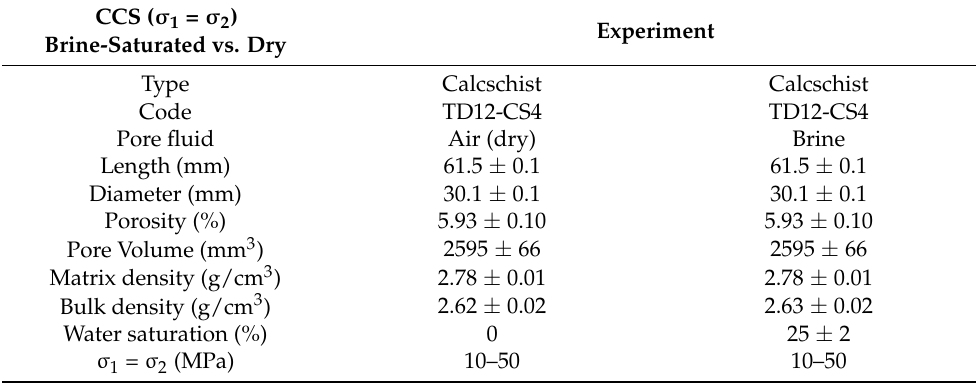
Table 9. Properties of the calcschist sample used to study the effect of a brine-saturated pore space on the seismic velocity. Note that the core sample used here was previously used in experimental series A (Table 2).